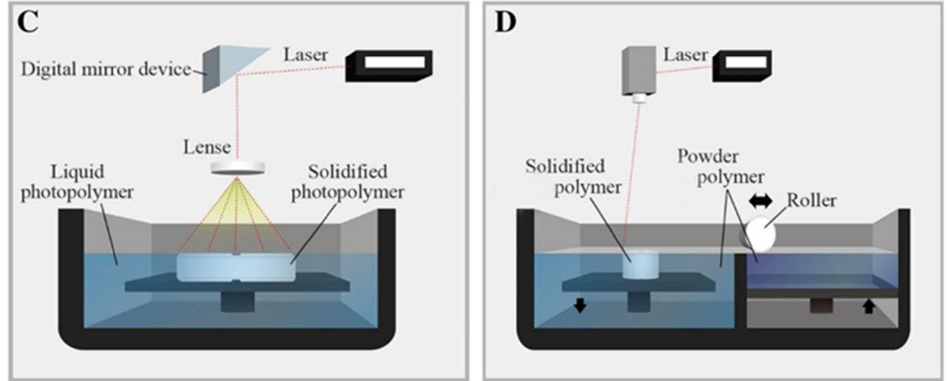
Figure 1. Graphical schemes of 3D printing techniques. ( A ). Fused deposition method (FDM) ( B ). Stereolithography (SLA) ( C ). Digital light processing (DLP) ( D ). Selective laser sintering (SLS). Reprinted with permission from ref. [2]. Copyright 2018 Springer Nature.